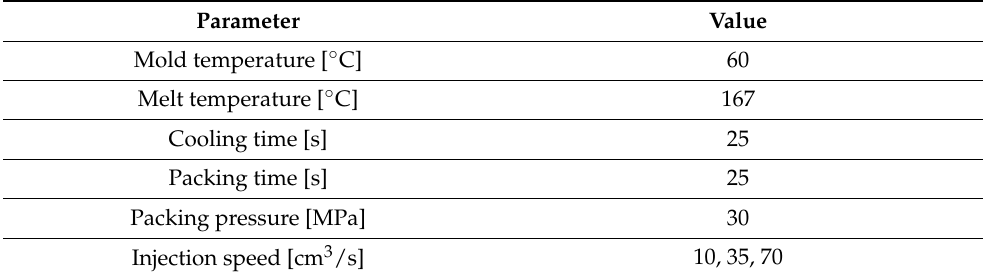
Table 4. Processing parameters of injection molding for molded